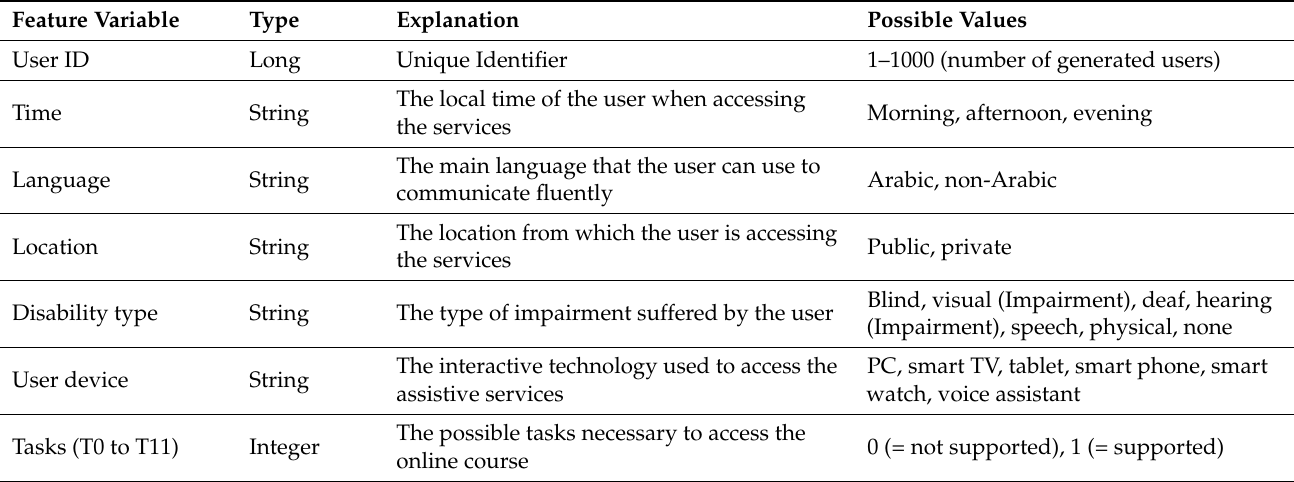
Table 3. Summary of feature variables of the first disabled users